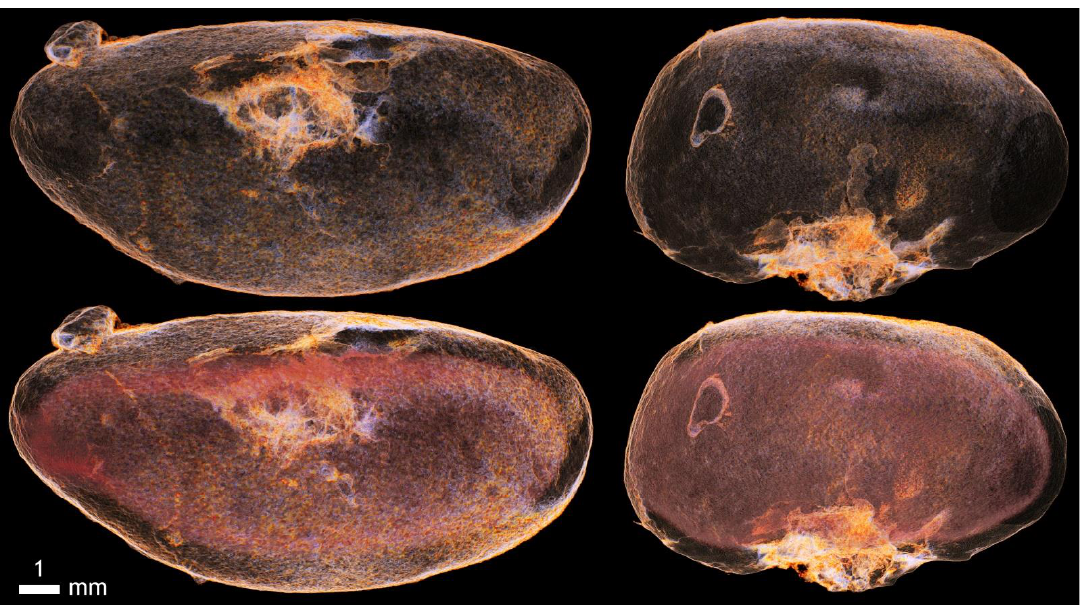
Figure A13. Iodine contrast and imaging of the kidney capsule, including the pathology of the cystic formation on the surface of the kidney.